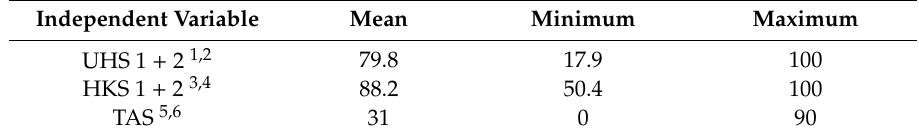
Table 5. Results (%) of 120 herd udder scorings.